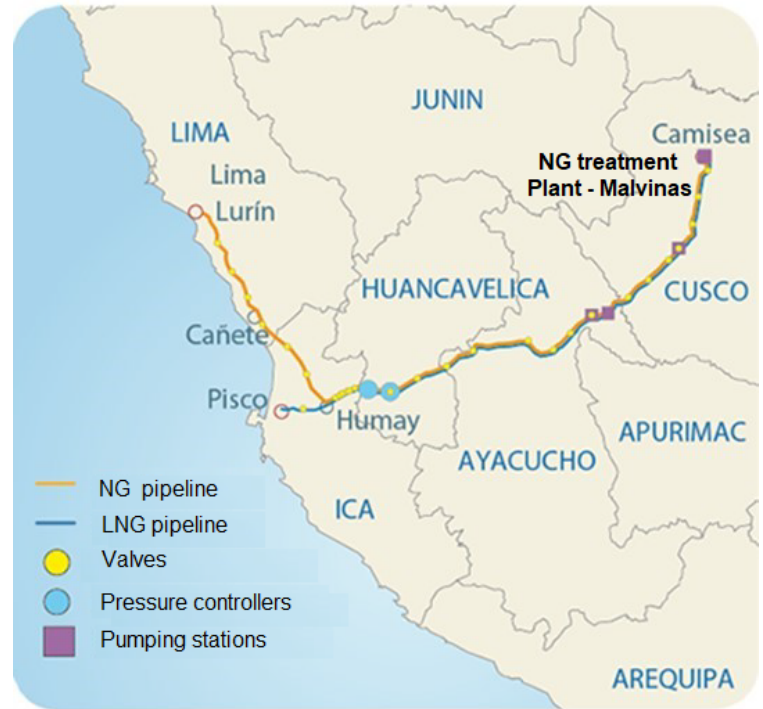
Figure 3. NG Transportation network (extracted from Osinergmin).